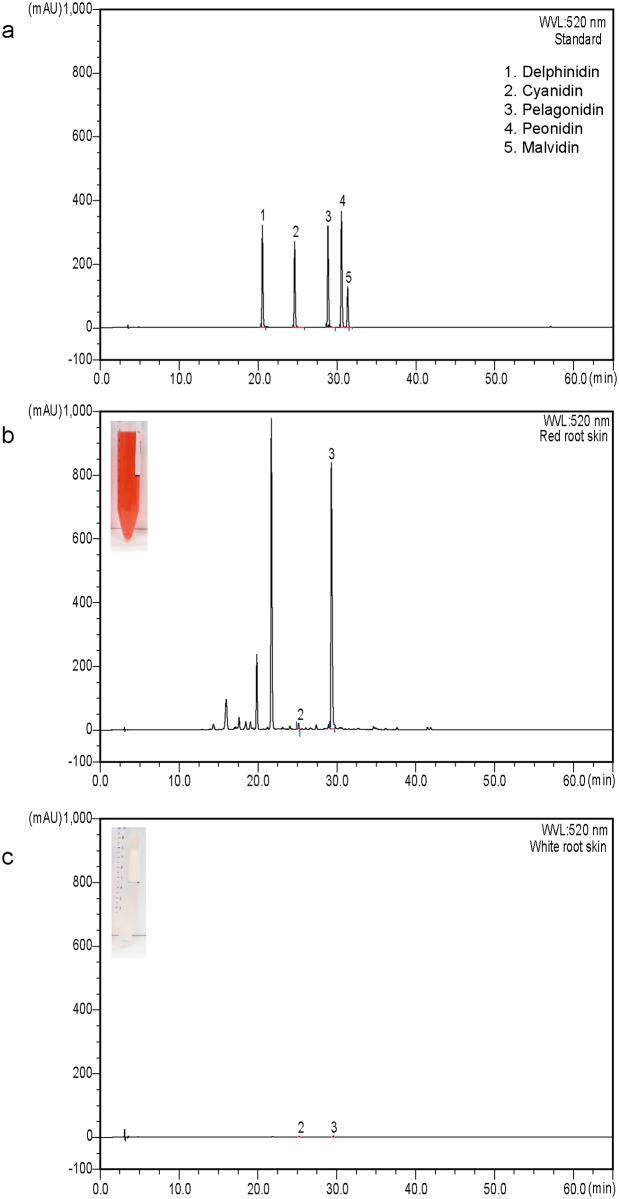
Pelargonidin is a major anthocyanidin in red root skin.HPLC analysis with standards (a), and root skin extracts of red (b) and white roots (c). Pictures for methanol extracts from the red and white root skins were depicted in inlets in (b) and (c), respectively.